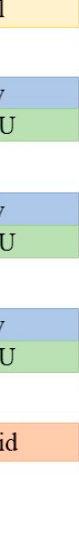
Figure 5. Architecture of the spatial structure enhancement model.